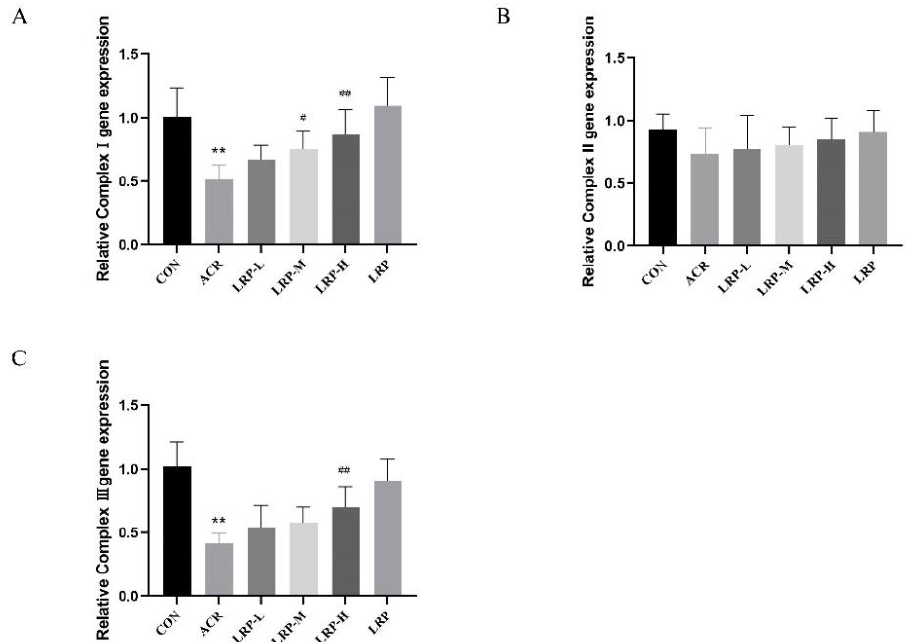
Figure 4. Effect of LRP on the mRNA expression of mitochondrial complexes I ( A ), II ( B ), III ( C ) induced by ACR in liver tissue. Data are expressed as mean ± SD. ** p < 0.01 versus the CON group; # p < 0.05 and ## p < 0.01 versus the ACR group. ACR, acrylamide; LRP-L, Lycium ruthenicum polyphenols in low dosage; LRP-M, Lycium ruthenicum polyphenols in medium dosage; LRP-H, Lycium ruthenicum polyphenols in high dosage; LRP, Lycium ruthenicum polyphenols control group.